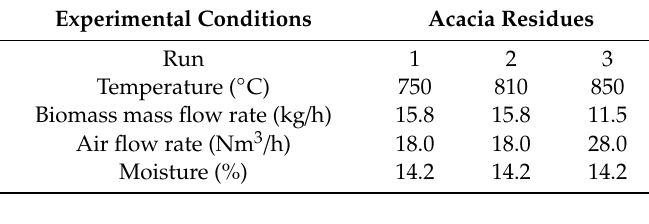
Table 7. Experimental operating conditions and syngas analysis.